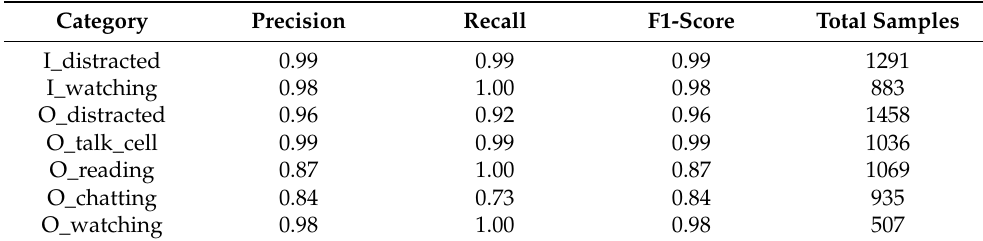
Table 6. Evaluation metrics of the VGG-19